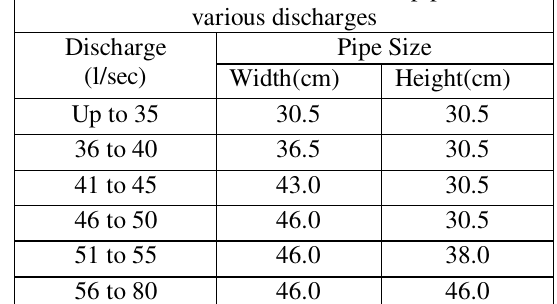
Table 2: Various sizes of lead-in pipe for various